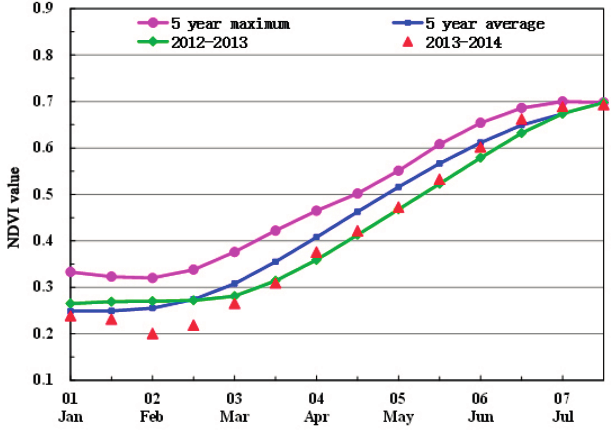
Figure 11. Spatial distribution of the VCIx between January and July 2014 in the CONUS.